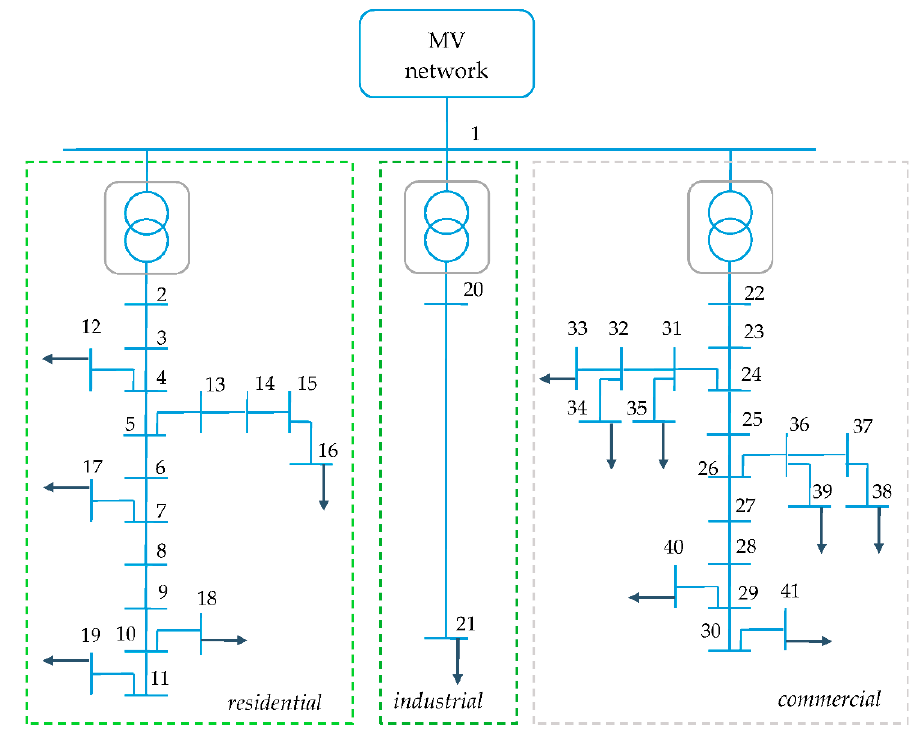
Figure 2. Cigr è low voltage (LV) test grid Figure 2. Cigrè low voltage (LV) test grid Table 5. Time of Use (ToU) Table 5. Time of Use (ToU) Tariff.